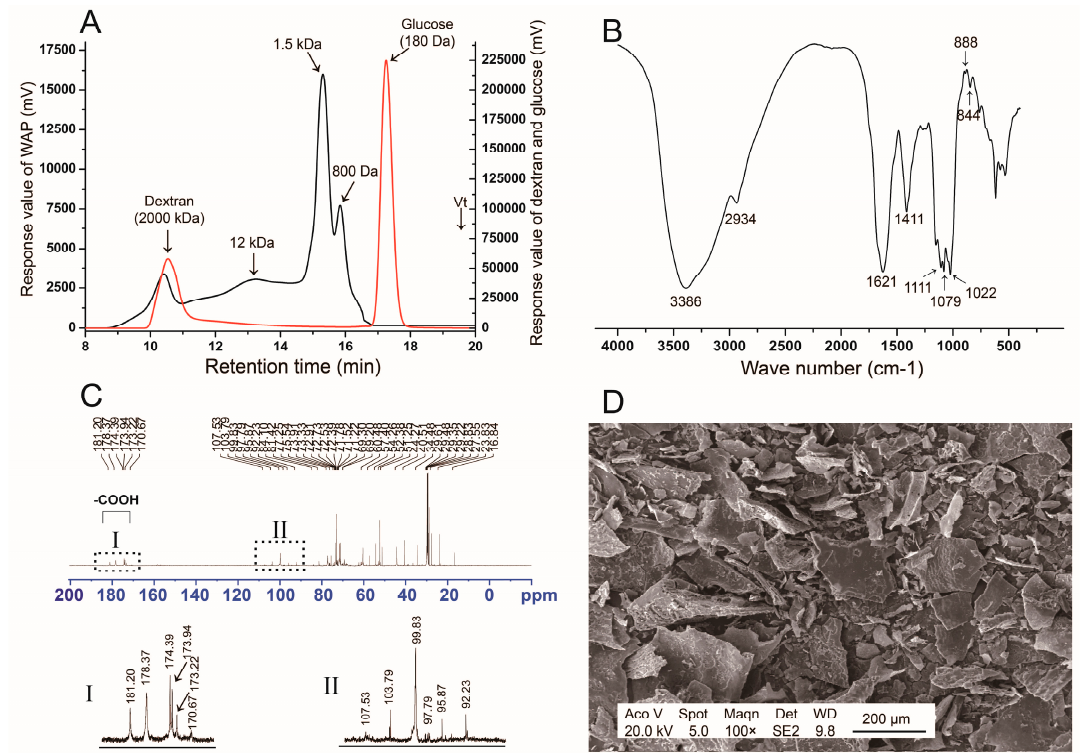
Figure 1. Structure analysis of WAP. ( A ) HPGPC profiles (Red line, dextran and glucose; Black line, WAP); ( B ) IR spectrum; ( C ) 13 C NMR spectrum; ( D ) SEM analysis.